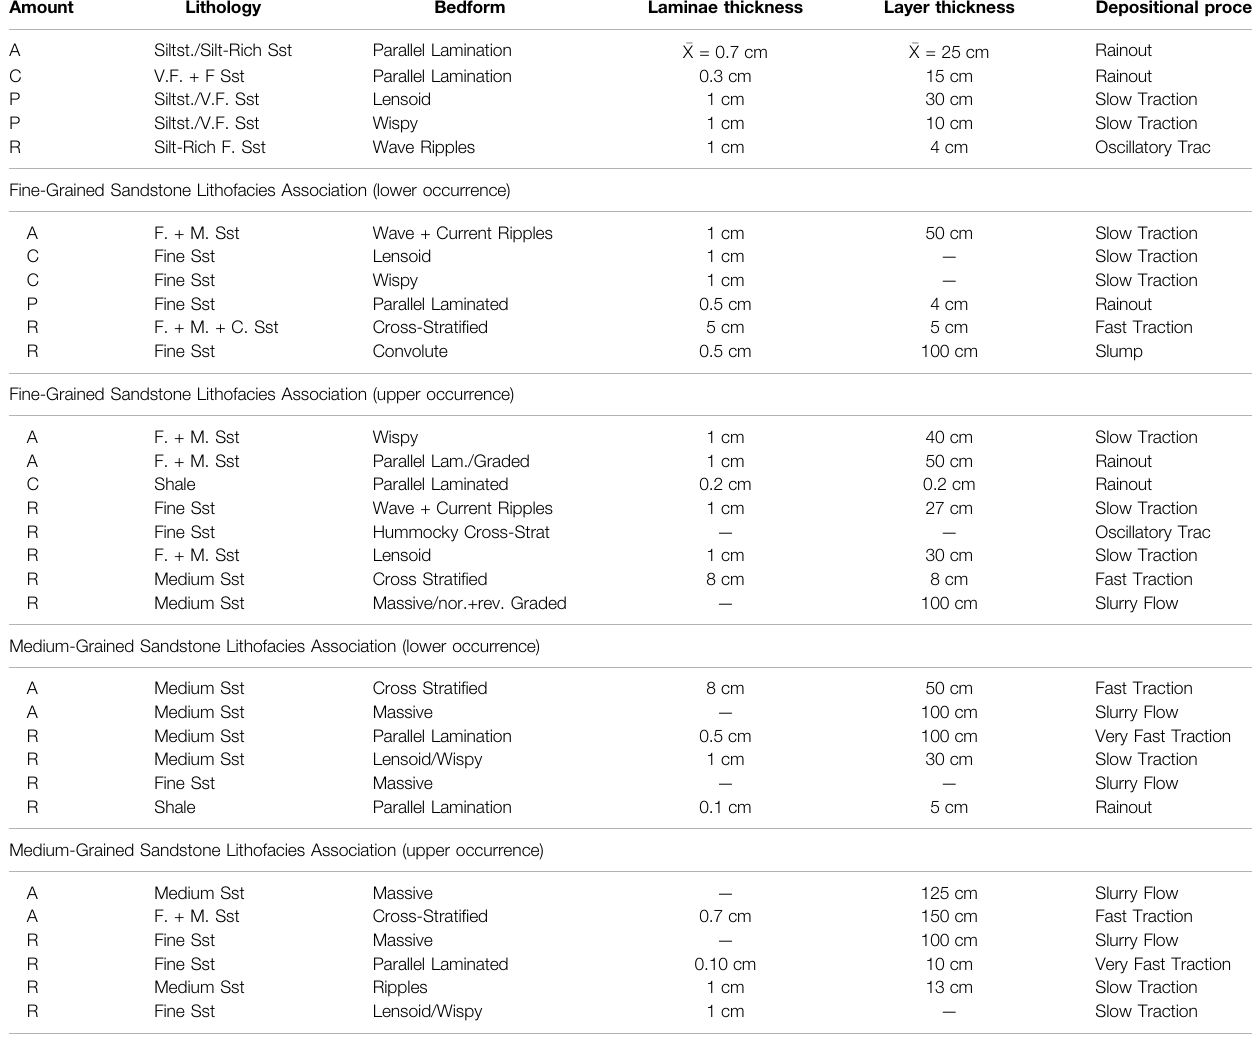
( Figure 5 ). Current ripple laminated, very fi ne-grained sandstone units are extremely abundant throughout this lithofacies association. ( Figure 5B ) siltstone with deformed sandstone lenses 0.2 – 0.5 cm thick, or in the case of wispy layers, swirled laminae that water escape and loading has made identifying the precursor dif fi cult. The units range from 20 to 197cm thick, averaging 70cm.